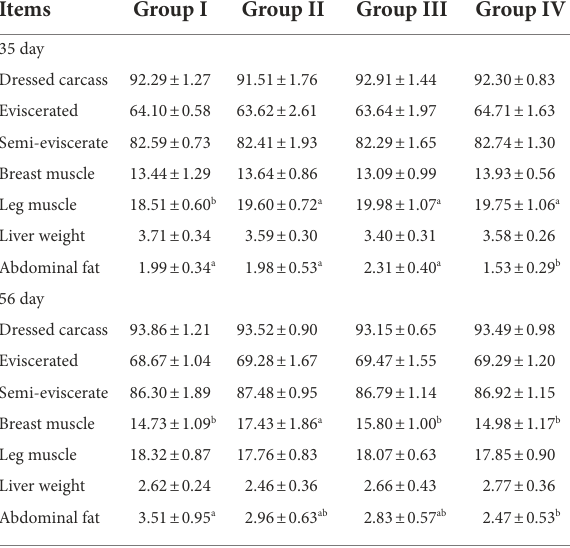
TABLE 5 Effects of different levels of FGSM on carcass attributes (%).